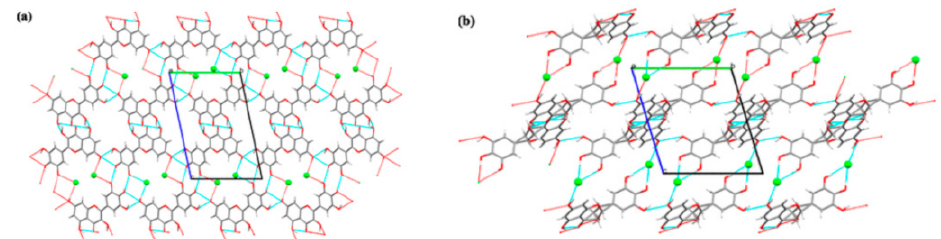
Figure 4. ( a ) Two-dimensional network formed between chloride anion and myricetin moieties via O–H · · · O and O–H · · · Cl – interactions viewed along the a-axis (capped stick model). ( b ) Two- dimensional network formed between chloride anion and dihydromyricetin moieties via O–H · · · O and O–H · · · Cl – interactions viewed along the a-axis (capped stick model) [64] (with permission from [64]; Copyright 2019 American Chemical